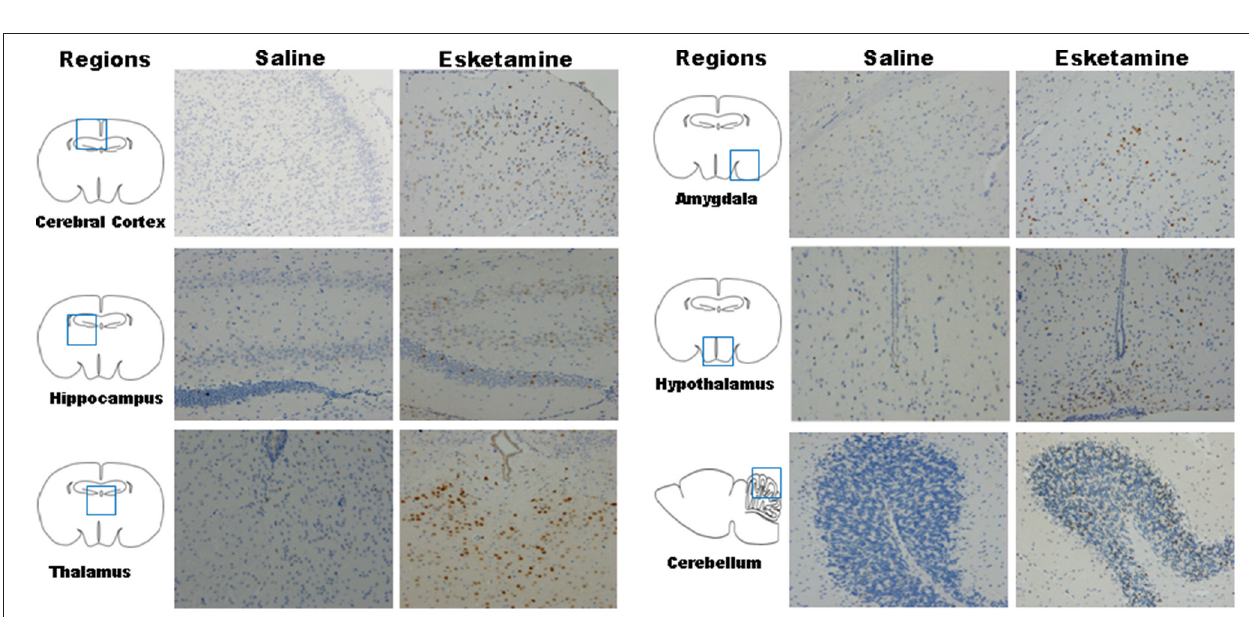
FIGURE 5 | c-Fos expression in mice brain regions including cerebral cortex, hippocampus, thalamus, amygdala, hypothalamus, and cerebellum after recovery ( × 200).